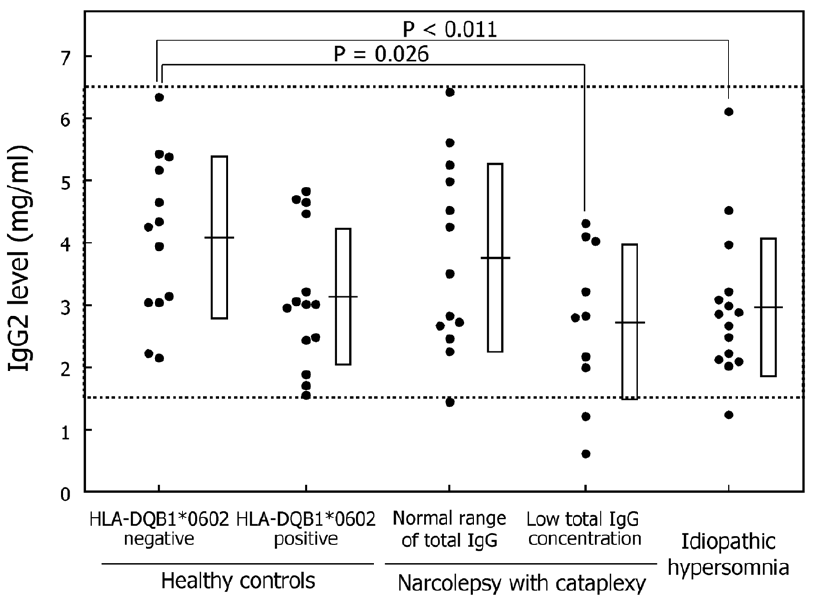
Figure 3. Serum IgG2 level. The definitions of dots, dotted lines, horizontal lines, and squares are provided in the legend for Figure 2.